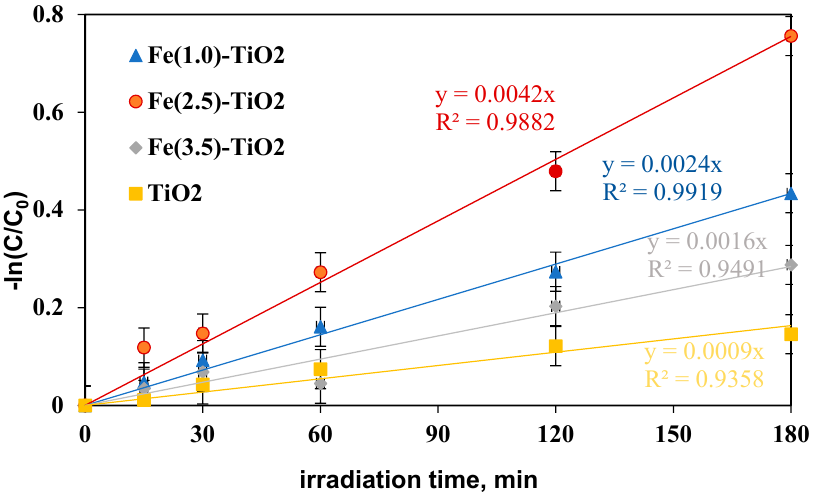
Figure 10. − ln(C/C 0 ) versus irradiation time (min) for evaluation of discoloration kinetic after 180 min of visible irradiation using undoped TiO 2 (yellow), Fe(1.0)-TiO 2 ( blue), Fe(2.5)-TiO 2 (red), and Fe(3.5)-TiO 2 (gray) photocatalysts.